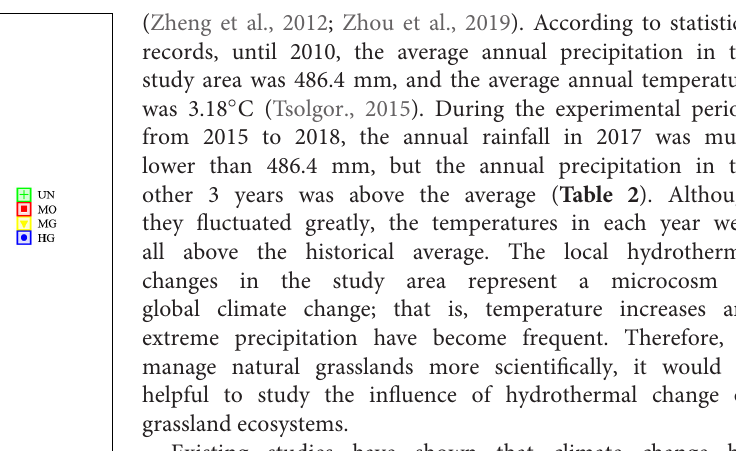
FIGURE 4 | Principal component analysis (PCA) of grassland plant community characteristics and soil physicochemical